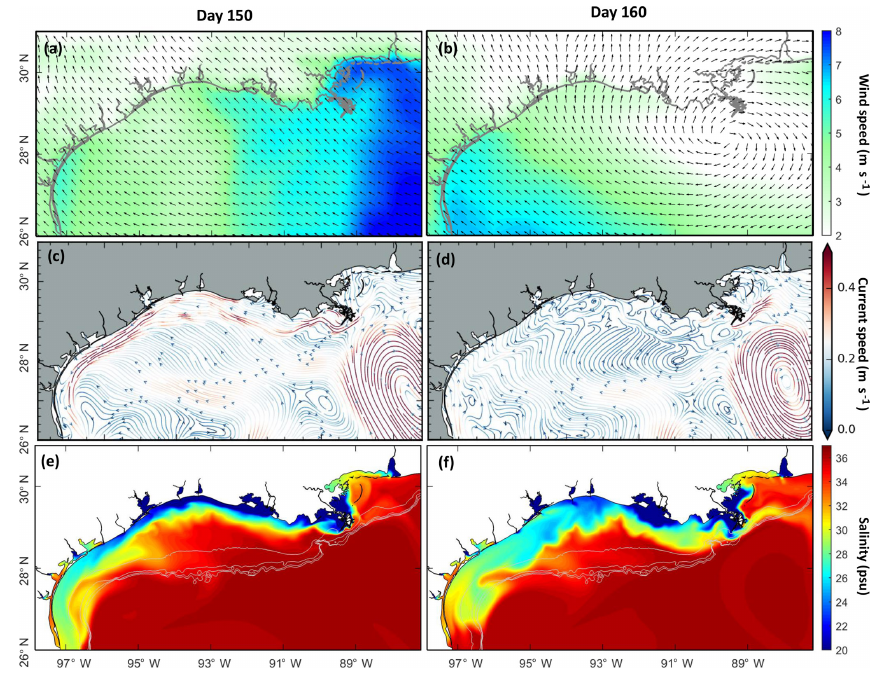
Figure 9. Comparison of the observed wind field and the modeled surface residual current and surface salinity on day 150 (31 May 2007) and day 160 (10 June 2017). The filled colors indicate the daily mean wind speed (a, b) , the speed of the residual current (c, d) , and salinity (e, f) .